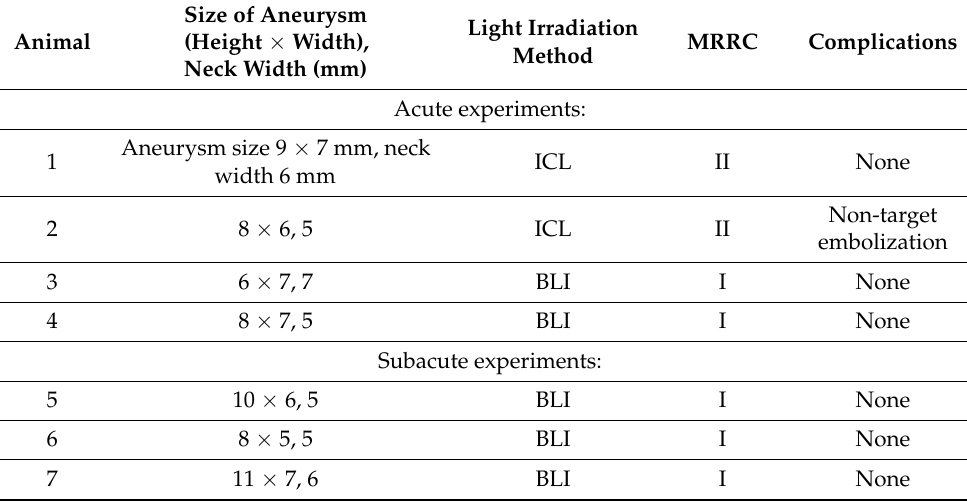
Figure 4. Venous pouch aneurysm in pig ( A ), with treatment using injection catheter lighting ( B – D ) or balloon lighting with intralipid ( E – G ). Pre-embolization angiography ( B ) showing the wide-necked aneurysm, fluoroscopy ( C ) showing the inflated balloon and PHP within the aneurysm, and post-embolization angiography ( D ) showing the PHP within the aneurysm and a small neck remnant. Pre-embolization angiography ( E ) showing the wide-necked aneurysm, fluoroscopy ( D ) showing the inflated balloon and PHP within the aneurysm, and post-embolization angiography ( F ) showing complete aneurysmal obliteration. Table 1. Acute and subacute animal model aneurysm results with PHP